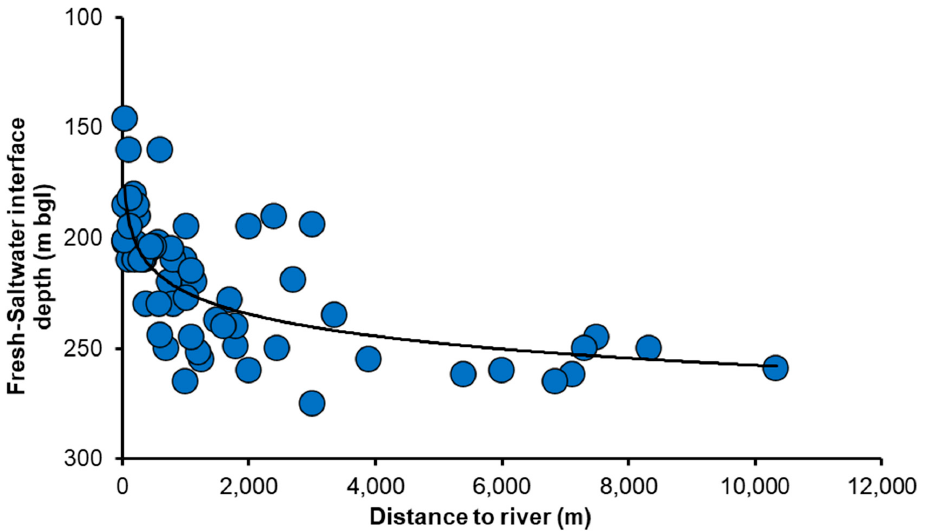
Figure 9. Graph showing freshwater–saltwater interface depth versus distance to the